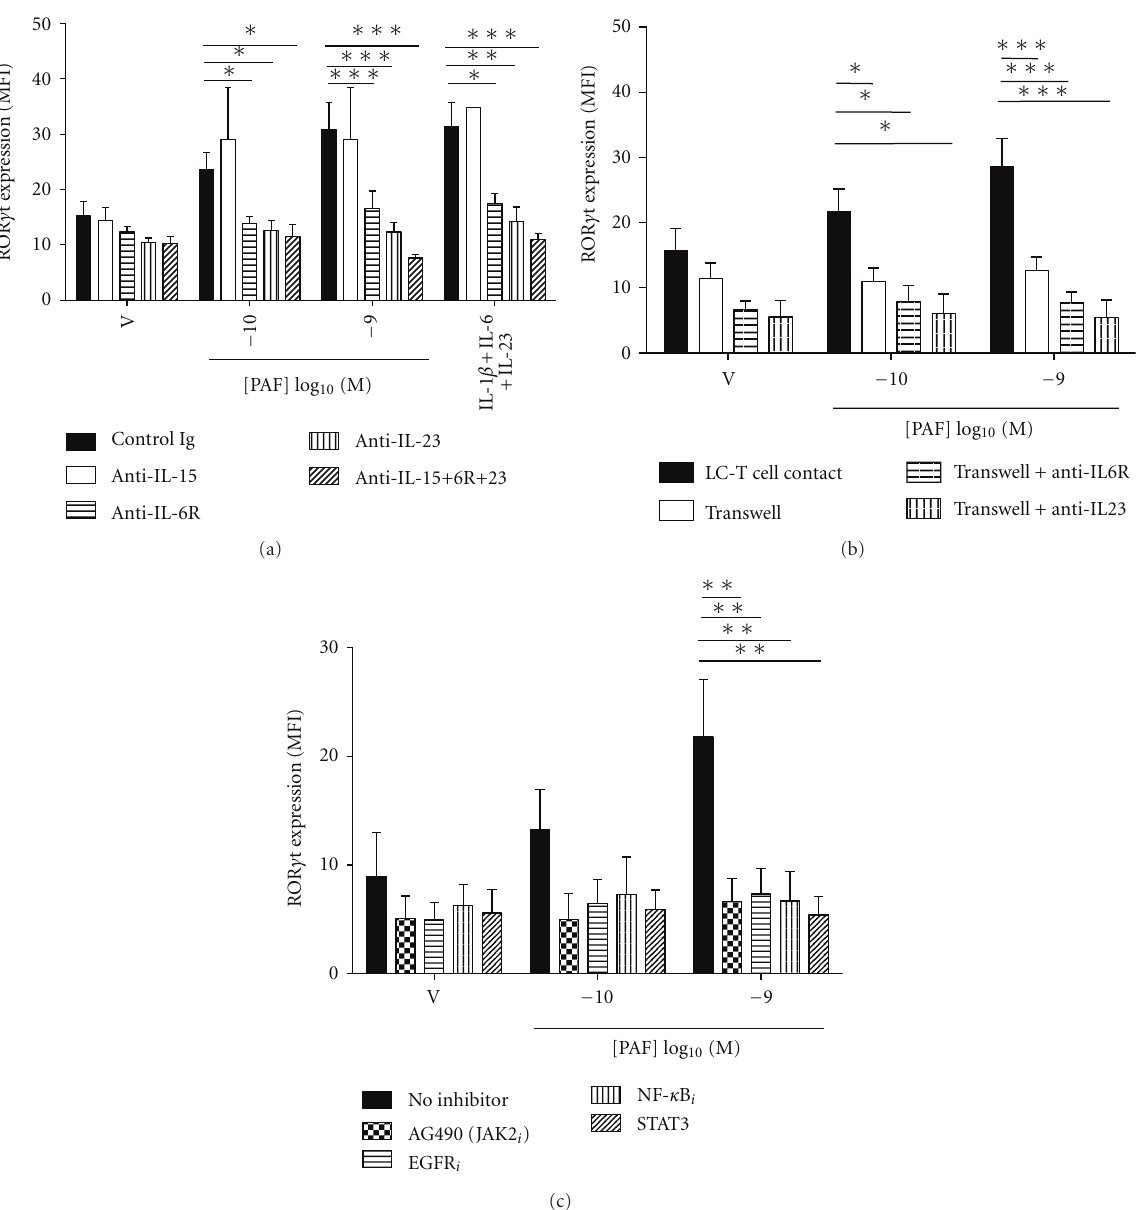
Figure 5: PAF-stimulated Th17 development is dependent on cytokines, LC-T cell contact and selected signaling pathways. (a) Monocyte- derived LC were stimulated with either vehicle or PAF in the presence of neutralizing Ab to IL-15, IL-6R, and/or IL-23, or control Ig, and cocultured with antiCD3/CD28-activated CD4 + T cells for 5 days. For comparison, CD4 + T cells were cultured alone with IL-1 β , IL-6 and IL-23 for 5 days in the absence or presence of the above-indicated neutralizing Ab. ROR γ t expression was measured by FACS in CD4 + T cells and expressed as geometric mean ( ± SEM) fluorescence intensity (MFI). n = 5; ∗ P < 0 . 05; ∗∗ P < 0 . 01; ∗∗∗ P < 0 . 001. (b) LC were stimulated with either vehicle or PAF and cocultured with antiCD3/CD28-activated CD4 + T cells for 5 days with direct LC-T cell contact or separated by a Transwell filter (LC in the top chamber, T cells in the bottom), in the absence or presence of neutralizing Ab to IL-6R or IL-23. ROR γ t expression was measured by FACS in CD4 + T cells and expressed as geometric mean ( ± SEM) fluorescence intensity (MFI). n = 5; ∗ P < 0 . 05; ∗∗∗ P < 0 . 001. (c) LC were stimulated with either vehicle or PAF and cocultured with antiCD3/CD28-activated CD4 + T cells for 5 days in the absence or presence of inhibitors of Jak2, EGFR, NF- κ B, or STAT3. ROR γ t expression was measured by FACS in CD4 + T cells and expressed as geometric mean ( ± SEM) fluorescence intensity (MFI). n = 4; ∗∗ P < 0 . 01; ∗∗∗ P < 0 . 001. ROR γ t expression in CD4 + T cells was prevented when LC were separated from T cells by a Transwell membrane, indicating that indeed PAF-induced Th17 development was also dependent on LC-T cell